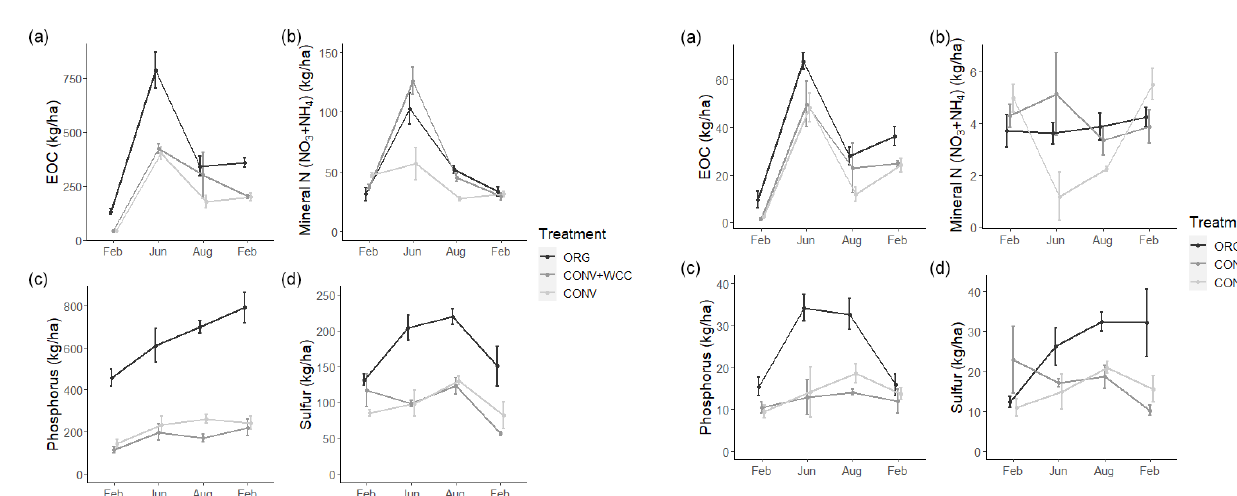
Figure 6. (a–d) Extractable organic C, mineral N (NO phosphorus, and sulfur in 0–100cm profiles of ORG, CONV + WCC, and CONV systems over the February 2018–February 2019 season. All values are given on a mass basis (kgha − 1 ). Error bars represent standard error.